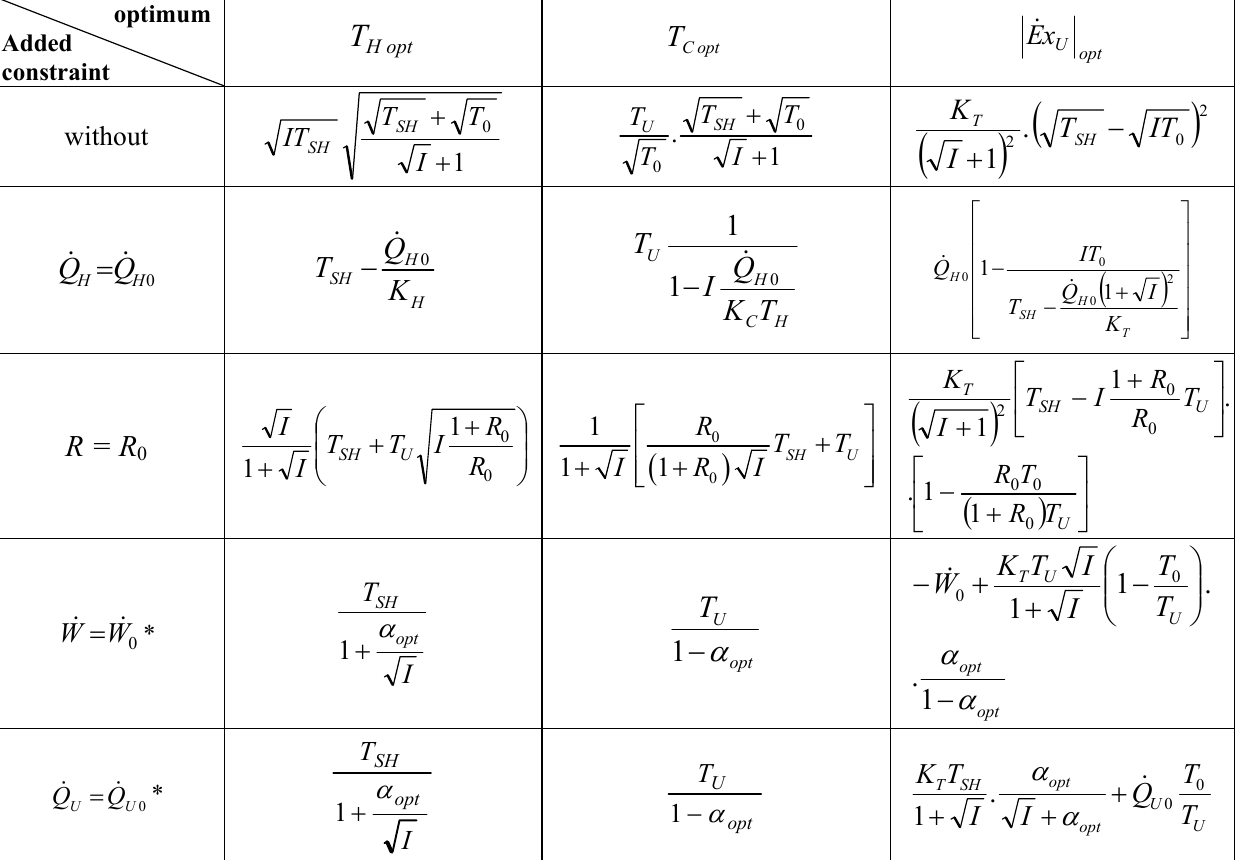
Table 1. Carnot CHP system optimization, with added constraint, and irreversibility ratio